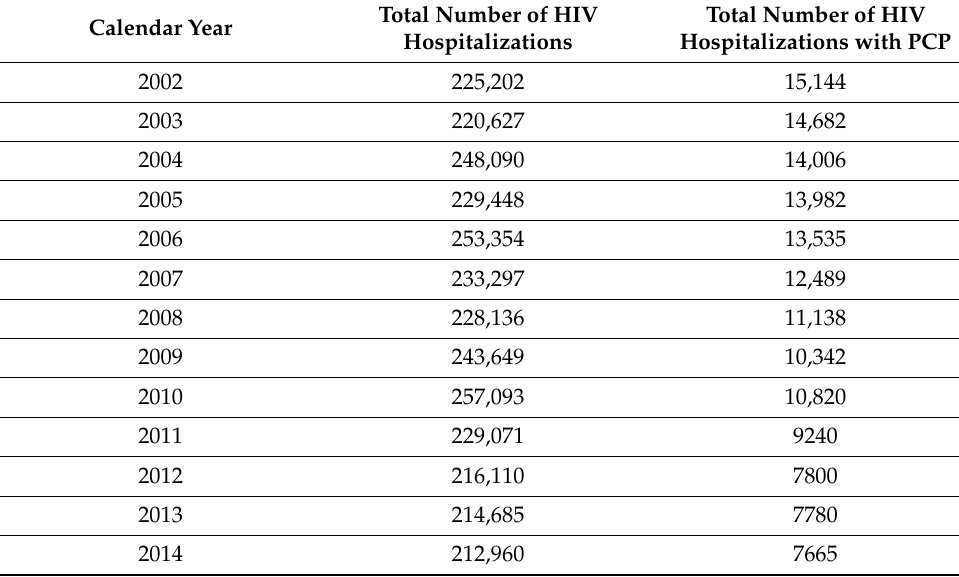
Table 2. Trends of hospitalization for HIV and Pneumocystis pneumonia in HIV